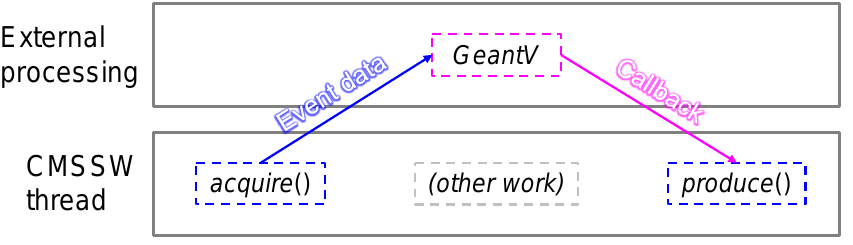
Figure 2. A diagram illustrating the asynchronous, non-blocking multithreaded processing enabled by E xternal W ork